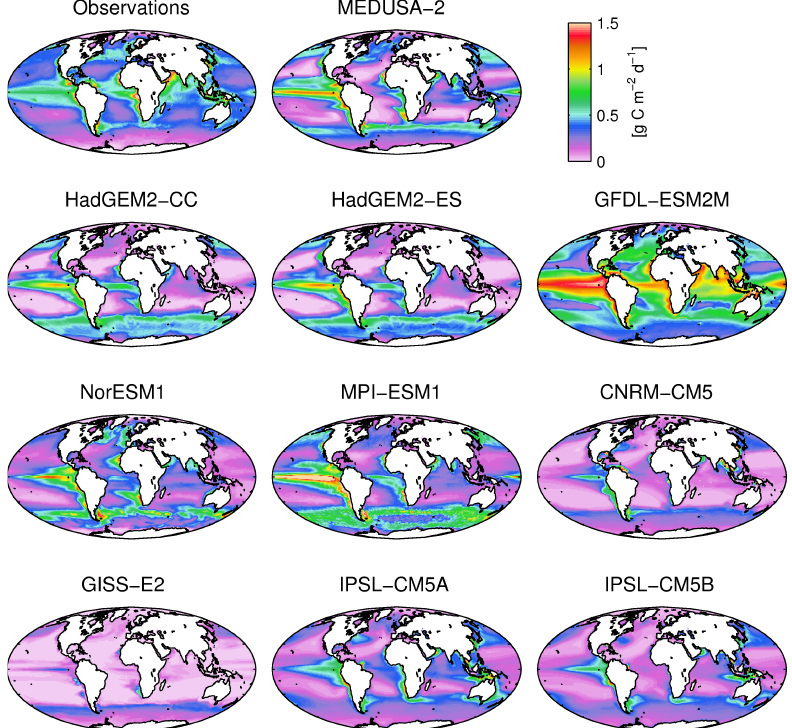
Fig. 45. Intercomparison of annual mean primary production for M EDUSA -2.0 and a range of comparable CMIP5 models. Primary production in gCm − 2 d − 1